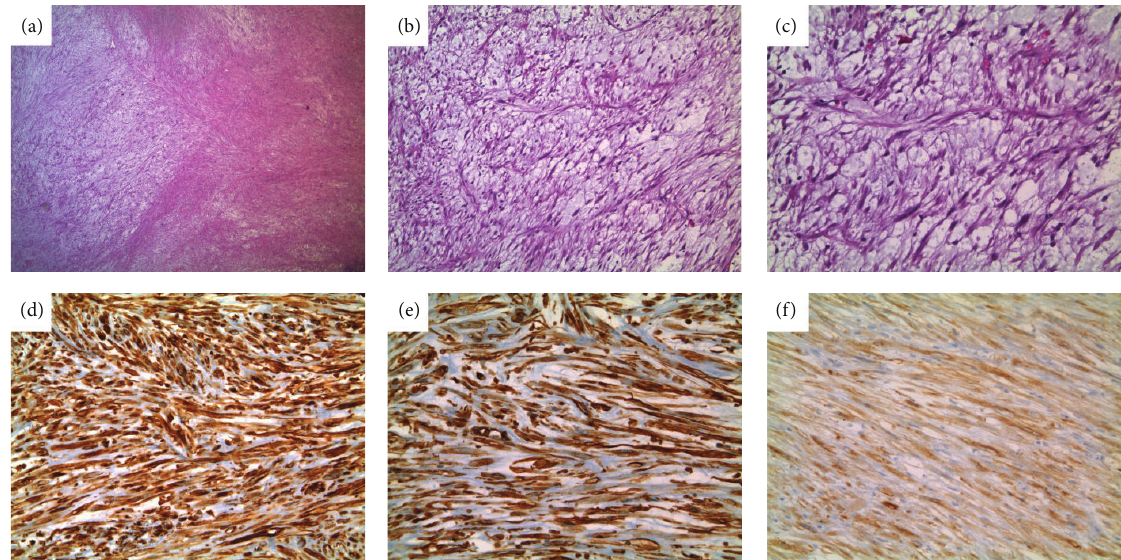
Figure 3: (a) A panoramic view of the inflammatory myofibroblastic tumor: note the cellular proliferation of spindled cells (H&E × 100). (b)-(c) Vesicular nuclei and eosinophilic cytoplasms, organized in a fascicular growth pattern ((b) H&E, × 150; (c) H&E × 200). (d) A widespread immunoreactivity for vimentin (immunoperoxidase stain for vimentin, × 200). (e) A positivity for smooth muscle actin (SMA) (immunoperoxidase stain for SMA, × 200). (f) A diffuse staining for anaplastic lymphoma kinase (ALK) (immunoperoxidase stain for ALK, ×